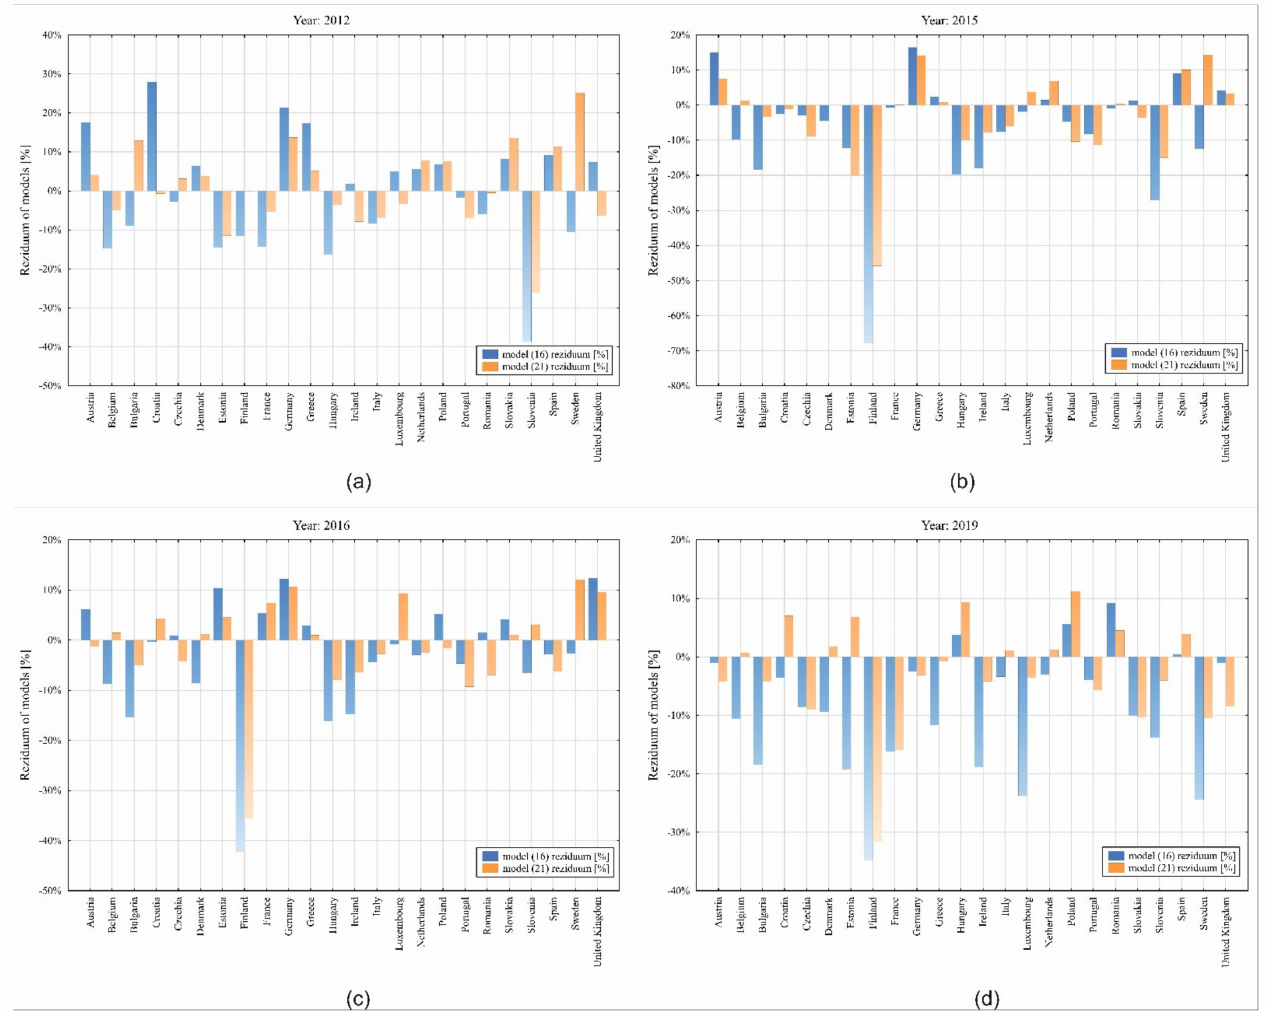
Figure 4. Relative value of residuals of analyzed models (16) and (21) according to monitored years and analyzed EU member countries. ( a ) 2012, ( b ) 2015, ( c ) 2016, ( d ) 2019. Source: Compiled and calculated by the authors using Statistica 13.5, Matlab2019b and JPM